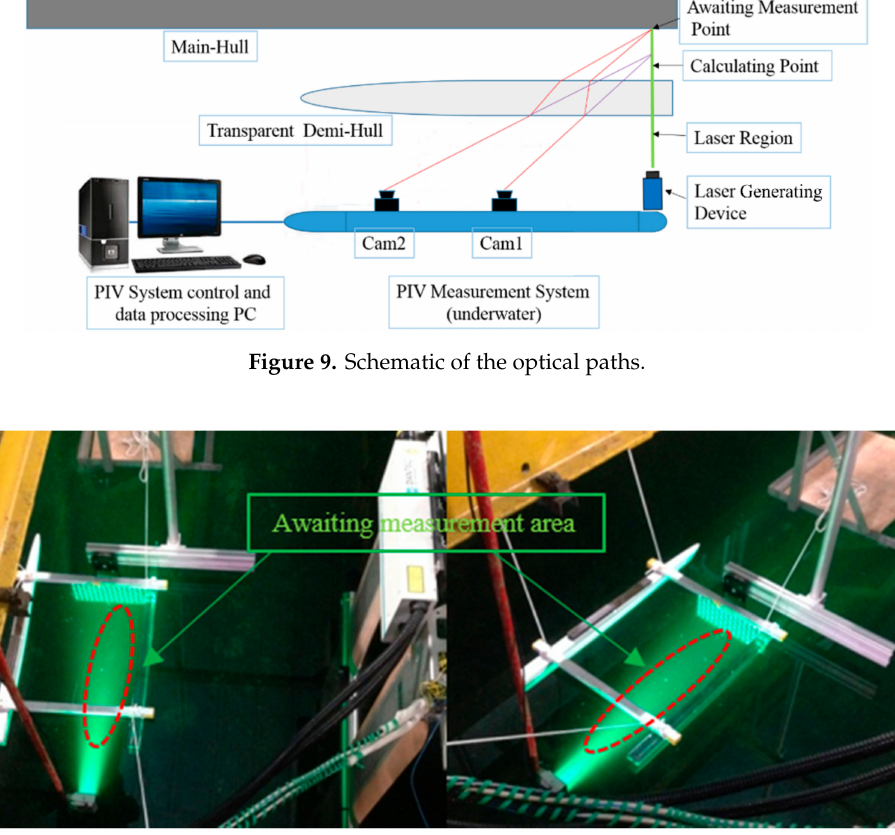
Figure 10. Calibration of the awaiting measurement